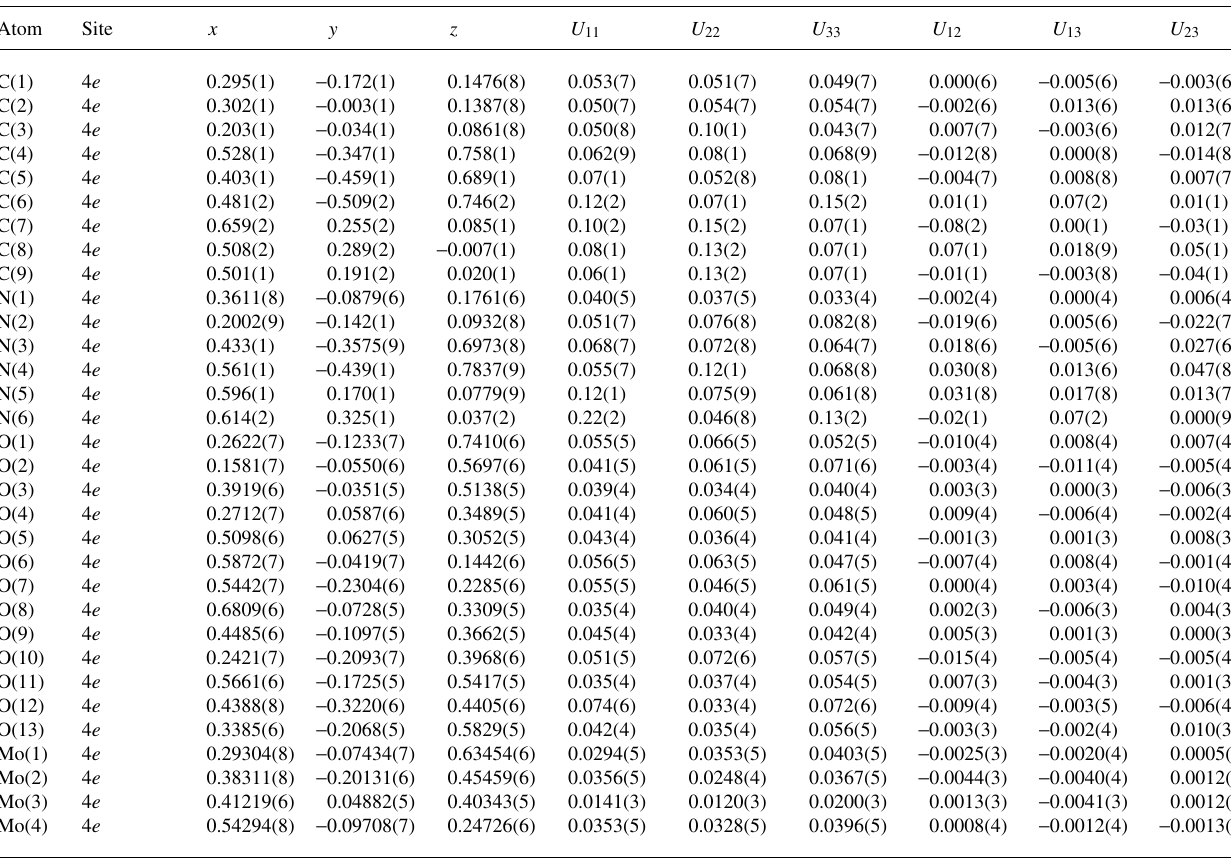
Table 3. Atomic coordinates and displacement parameters (in Å 2 ) .